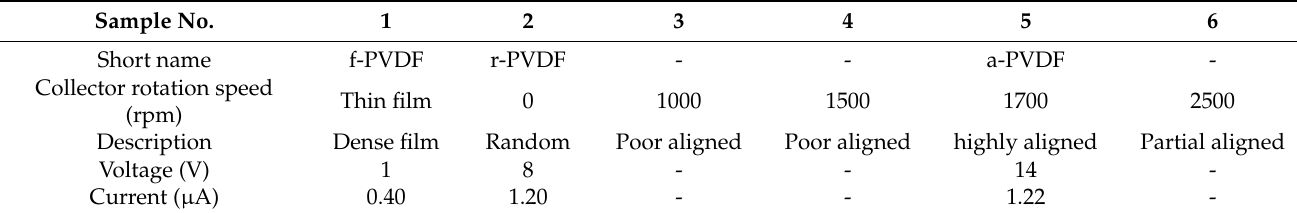
Table 1. Sample information and performances of PVDF-based piezoelectric nanogenerators. Sample